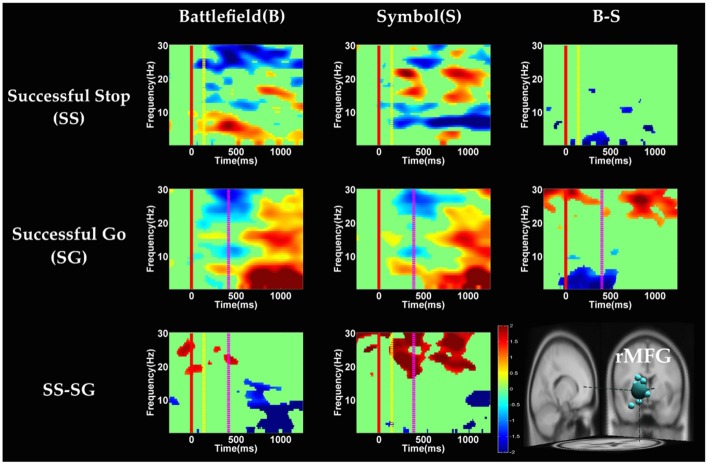
The ERSP images of rMFG cluster under inhibitory control. Red solid line: onset of the go stimulus; yellow dash line: onset of the stop signal; purple dash line: onset of response; color bars indicate the magnitude of the ERSPs; statistical threshold at p < 0.01.